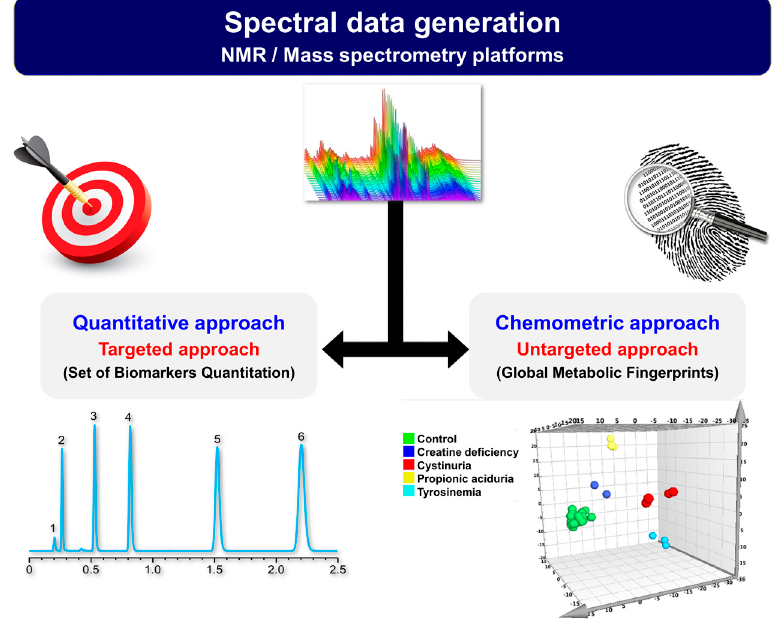
Figure 2. Clinical metabolomics implementation strategies.